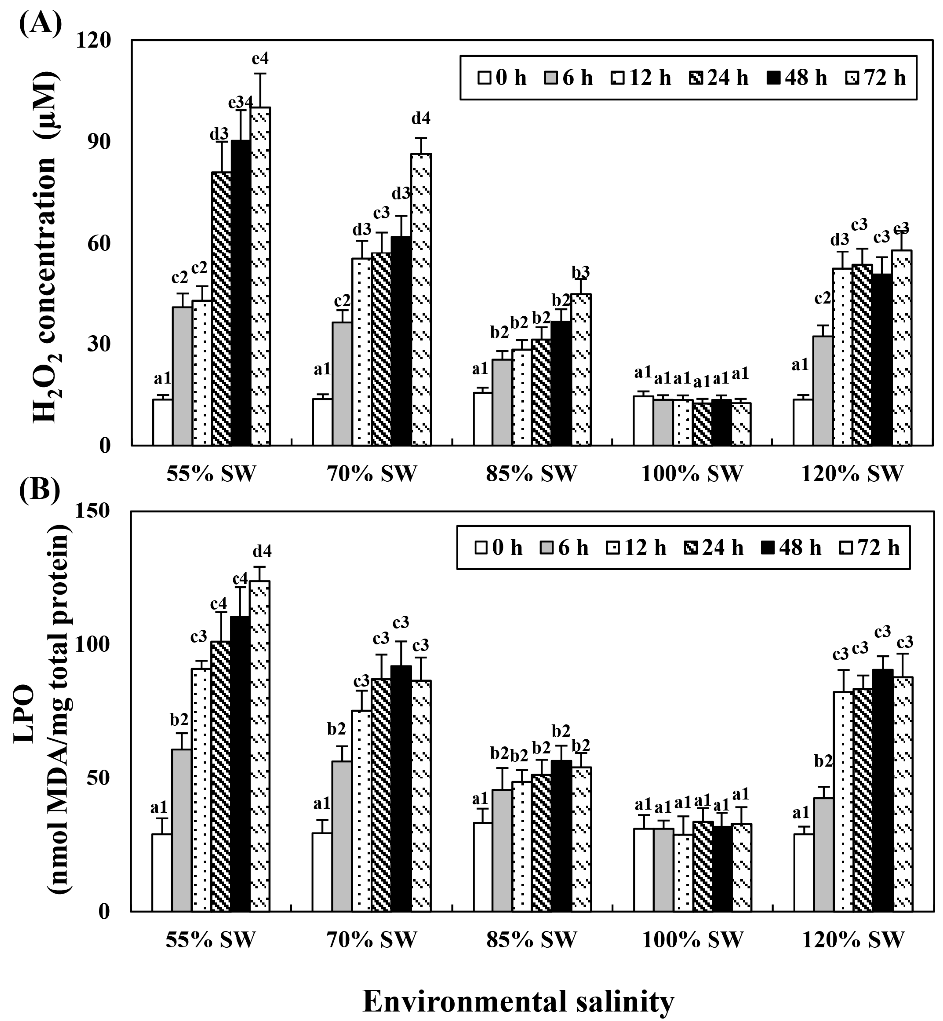
Figure 4. Concentration of ( A ) H 2 O 2 and ( B ) LPO in the hemolymph of A. irradians during a 72 h period after sudden salinity change. Different characters indicate values corresponding to different exposure times of the scallops within the same salinity concentration ( p < 0.05). Numbers indicate significant differences among salinity concentrations for the same exposure time ( p < 0.05). All values are presented as the mean ± SD ( n = 5). Abbreviations: H 2 O 2 , hydrogen peroxide; LPO, lipid peroxidation; and SD, standard deviation.